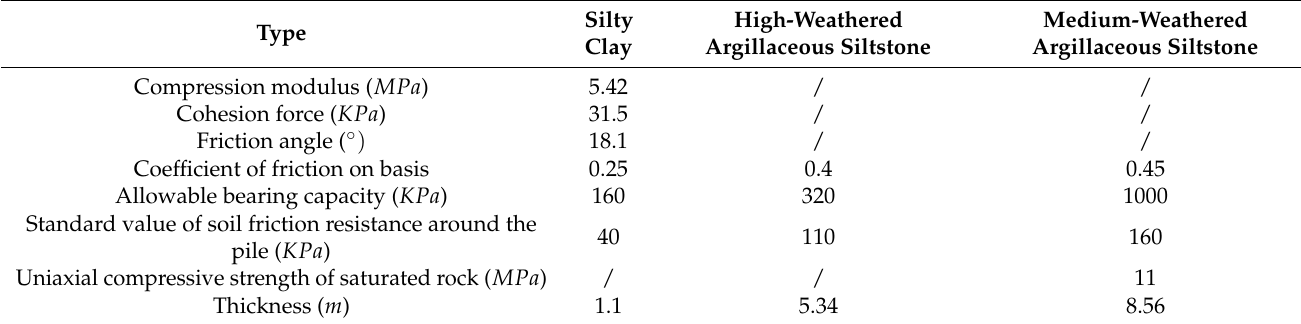
Figure 4. The elevation of the test pier. (Units: cm ) According to the design data, the mechanical properties of rock and soil layers at the bridge site are shown in Table 1. Table 1. Mechanical properties of rock and soil